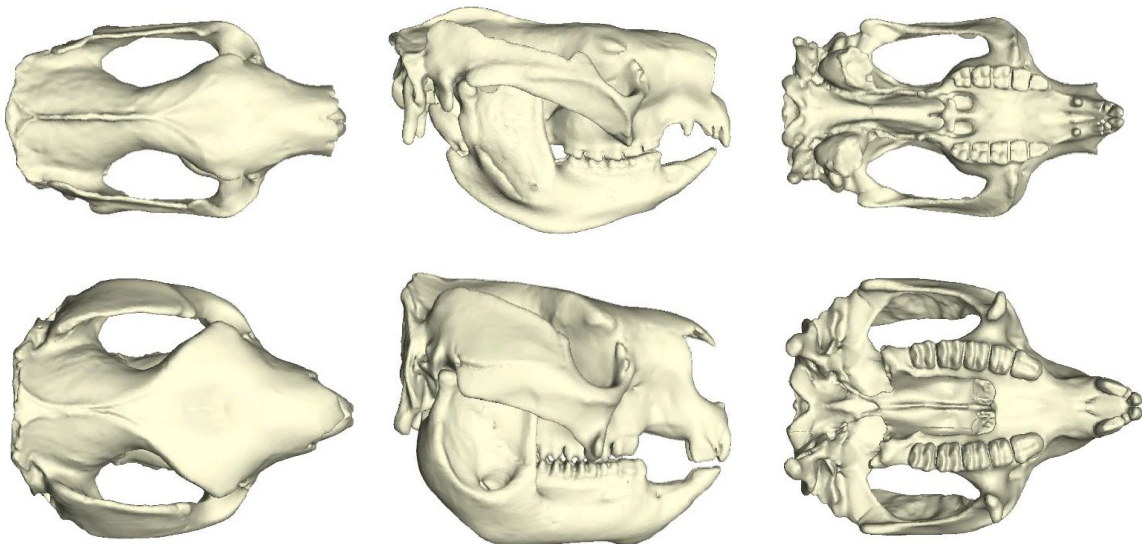
Fig 1. A comparison between the skulls of the koala (top) and Simosthenurus occidentalis (bottom). Views from left to right are dorsal, lateral, and ventral.